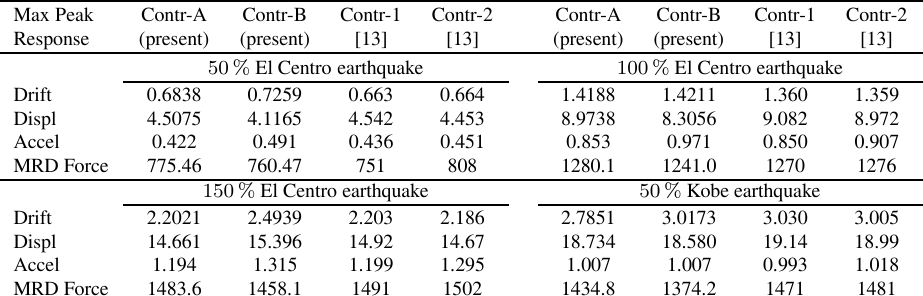
Table 6 Comparison of OSOF with robust reliability-based control of [13], (Drift/Displ - cm, Accel - g, Force -